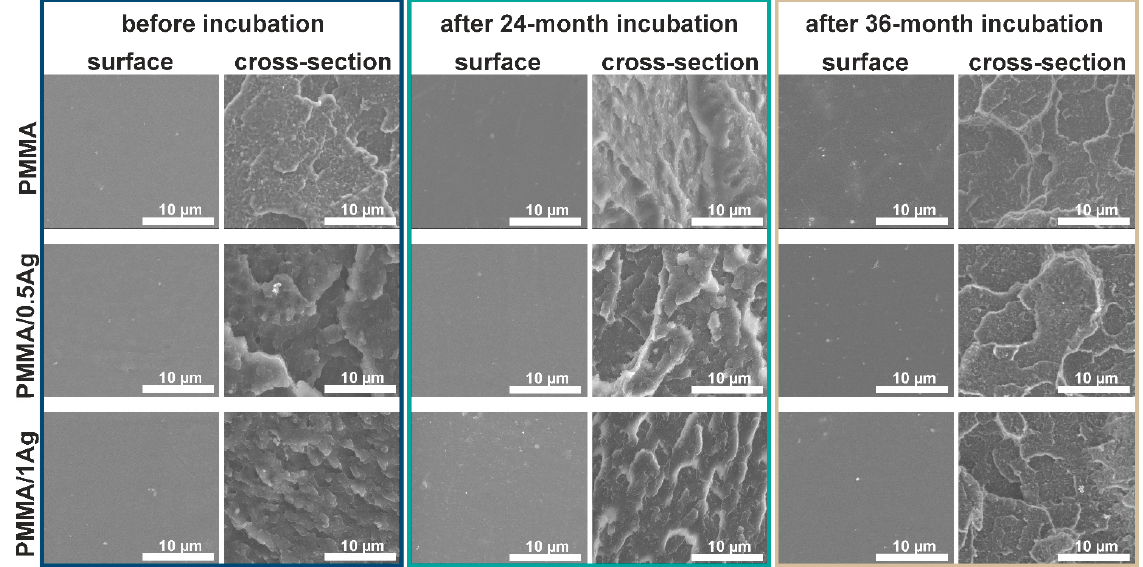
Figure 2. SEM images of surface and cross-section of polymethyl methacrylate acrylic (PMMA) and PMMA-based composites modified with 0.5 wt.% and 1.0 wt.% AgNPs before and after the 24- and 36-month incubation periods in deionized water.